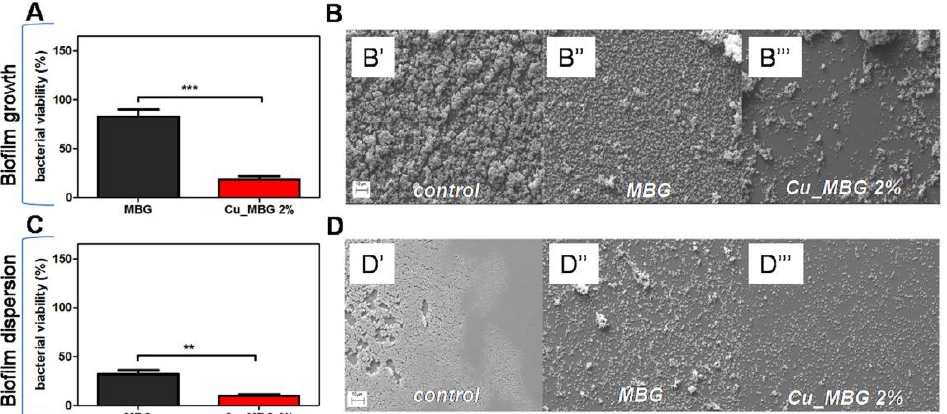
Figure 3. Bacterial viability and morphology of biofilms treated with MBG and Cu_MBG 2% sus- Figure 3. Different samples were added into S. epidermidis RP62A biofilm formation cultures. ( A ), ( C ) Bacterial viability and ( B ), ( D ) SEM images of the morphology of biofilms growth and dispersion pensions. Both suspensions were added to S. epidermidis RP62A biofilm formation cultures ( A ) or for control mBG and mBG with 2 wt% of Cu. Reproduced from [88]. after the formation of a stable staphylococcal biofilm ( C ). Bacterial viability is designed by *** and ** for ( A ) and ( C ) experiments respectively. SEM representative images of the staphylococcal biofilms formed in the absence (control) or in contact with both types of nanoparticles for 24 h are shown ( B ). SEM images of post formed biofilms, untreated (control) or treated with both MBG or Cu_MBG 2% nanoparticles for 24 h, are shown ( D ). Reproduced from